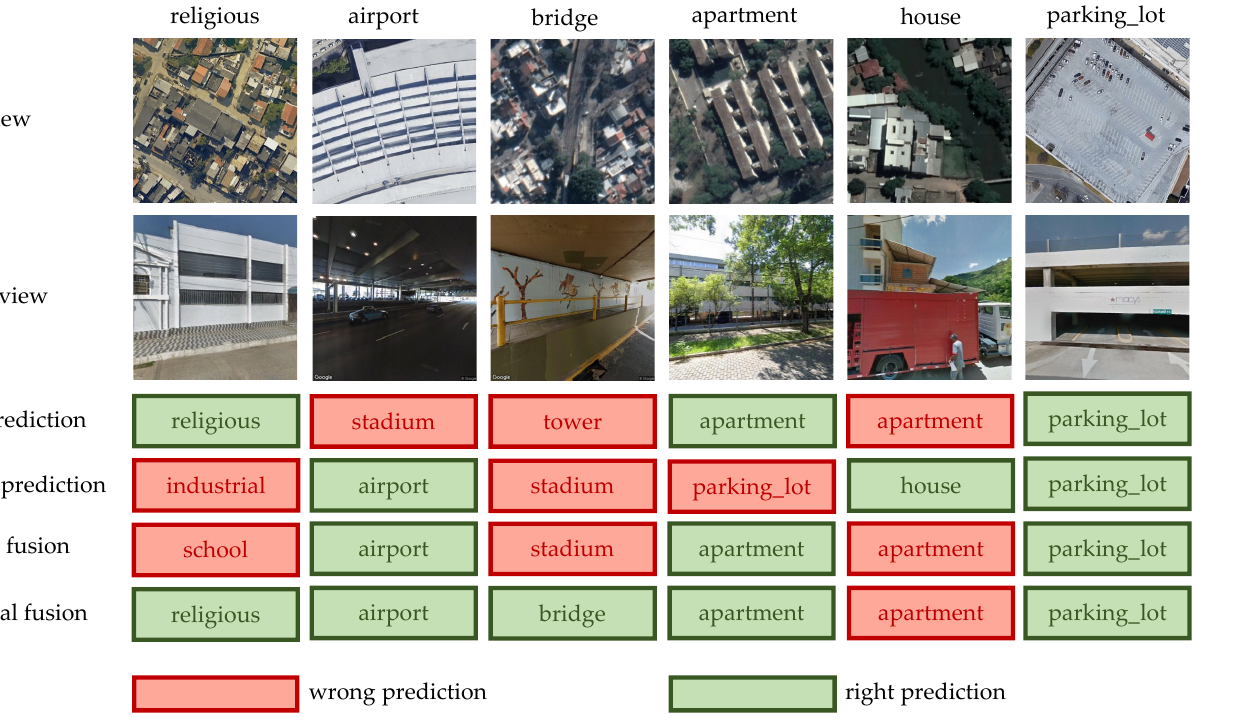
Figure 9. Examples of predictions by single views, the product fusion and the proposed evidential